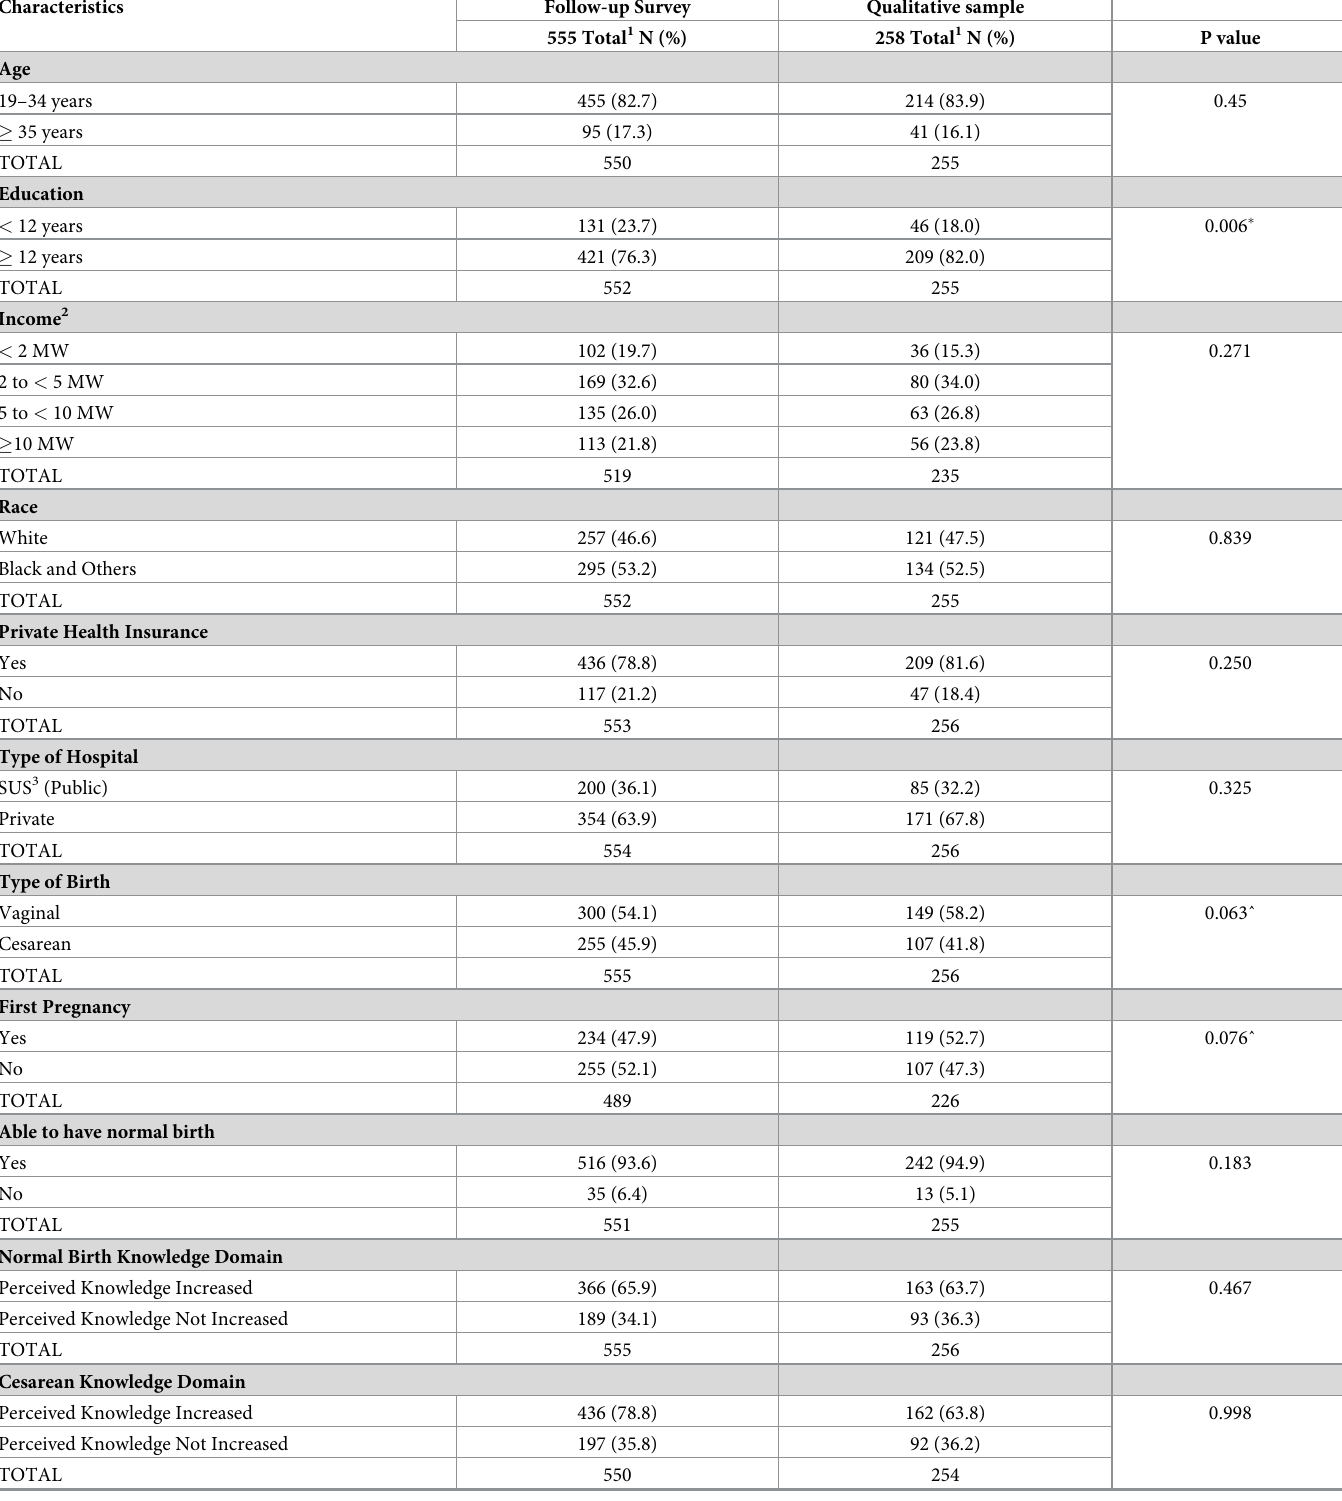
Table 1. Characteristics of women who participated in the SoB intervention (follow-up and qualitative analysis). Brazil 2015–2016.